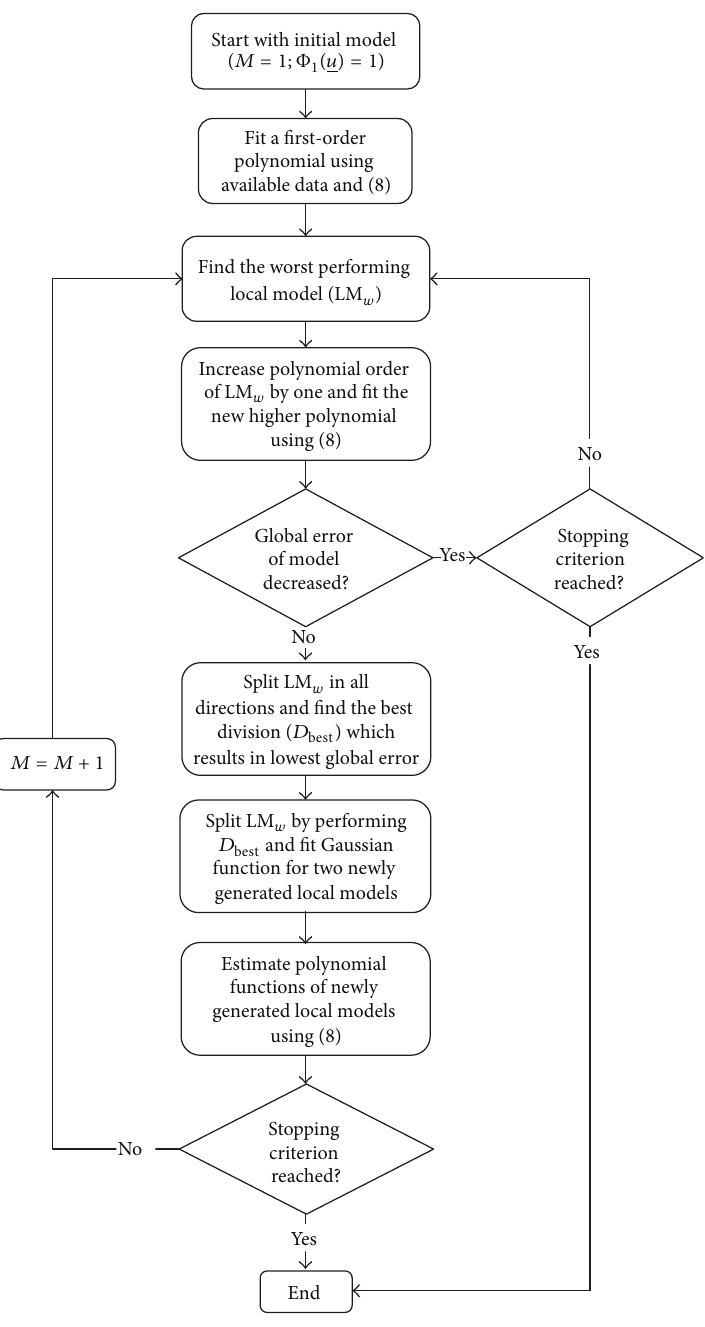
Figure 2: Flowchart of POLYMOT learning algorithm.